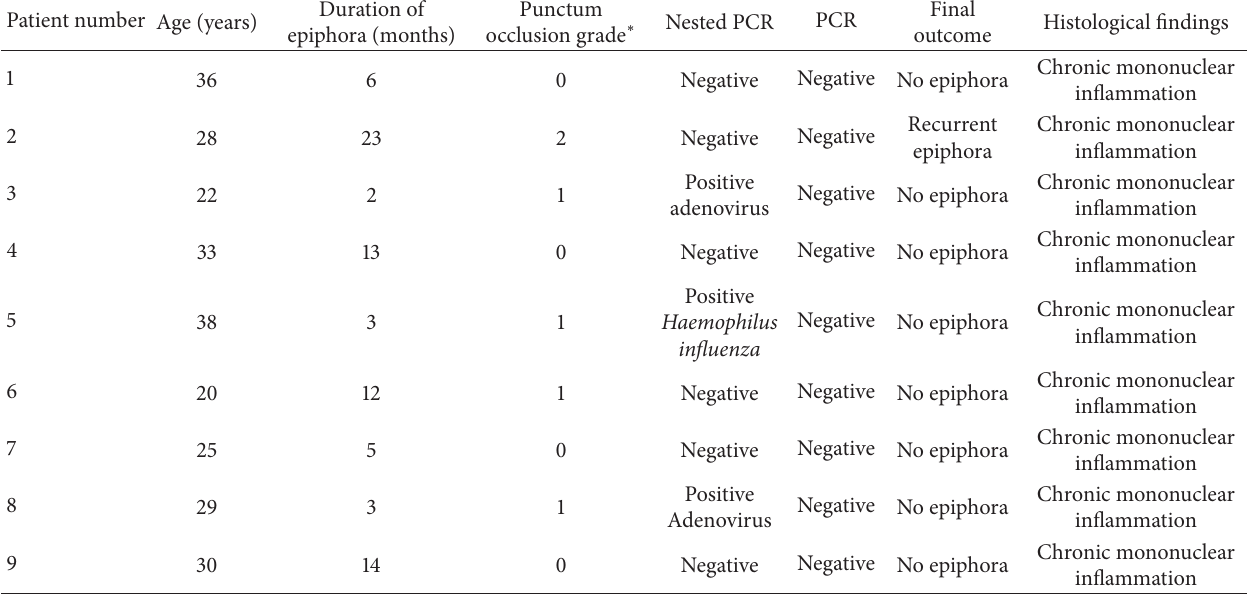
Table 2: Clinical characteristics of the study population.